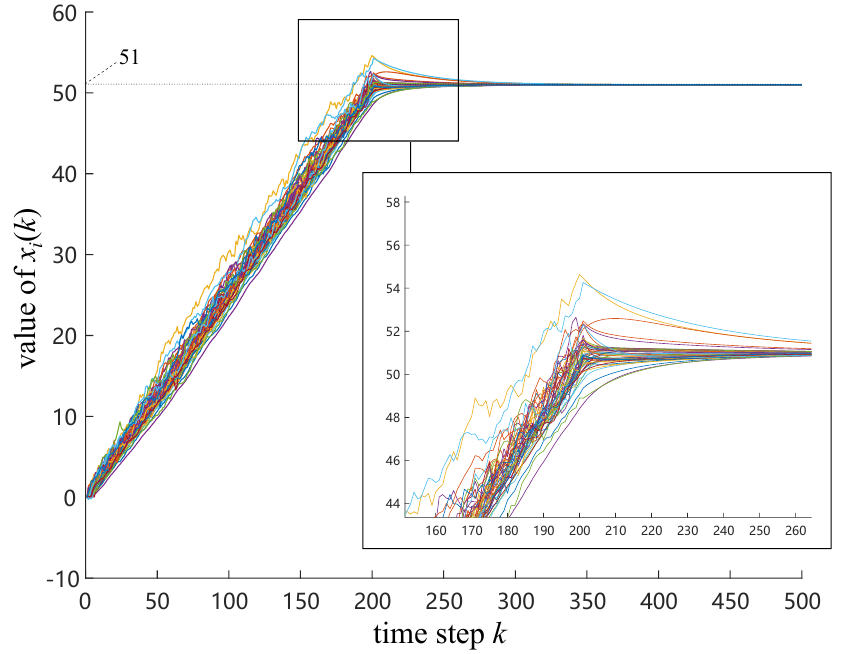
Figure 16. States evolution under normal distribution of r i ( k ) .